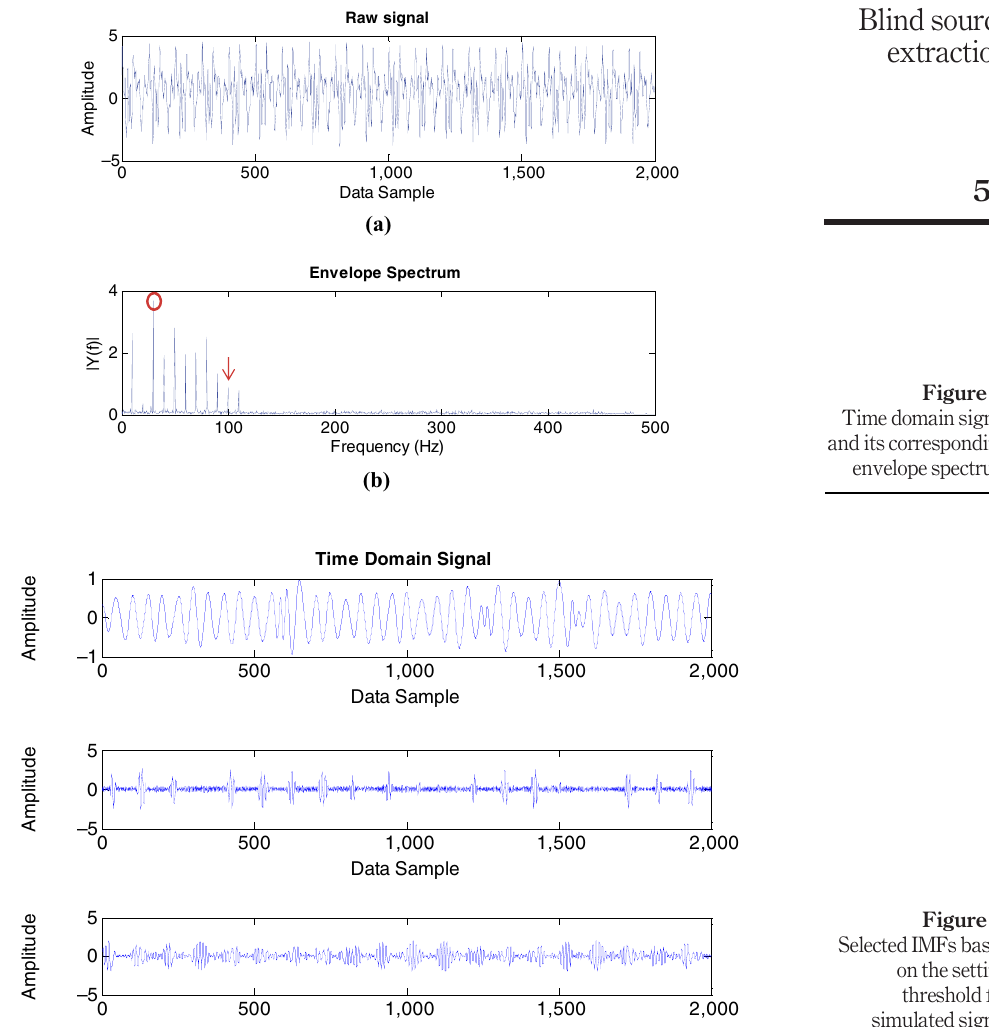
Figure 3. Selected IMFs based on the setting threshold for simulated